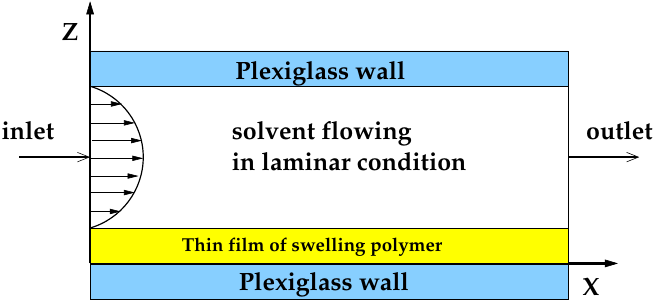
Figure 1. Schematic representation of the flow-through